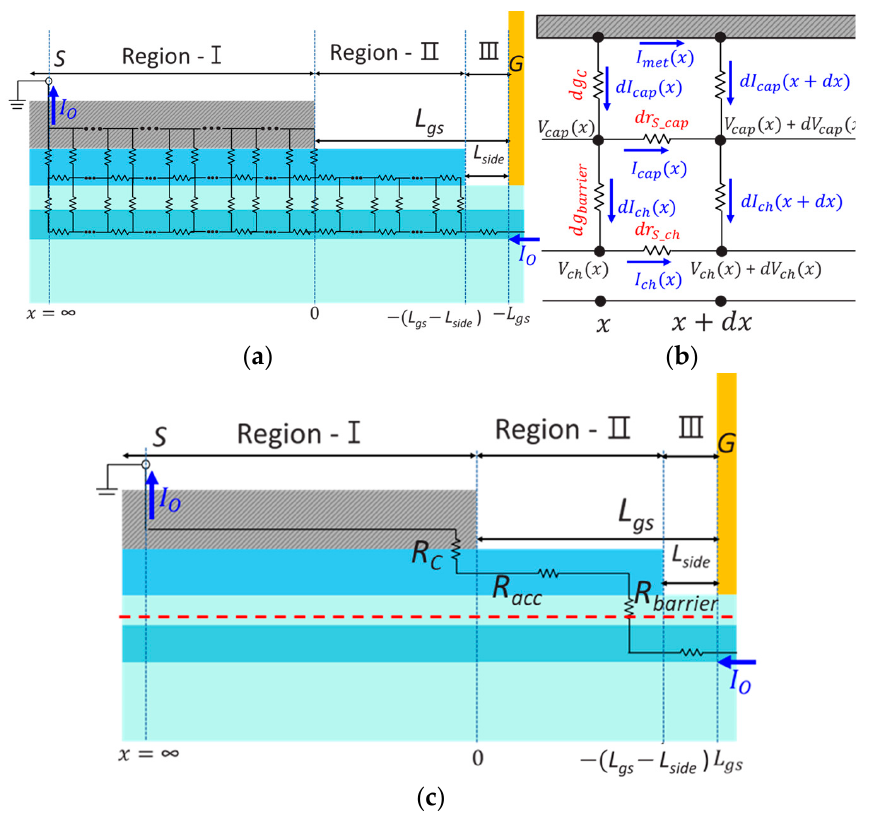
Figure 2. ( a ) Equivalent circuit model of the source structure in the advanced HEMTs, ( b ) differential segment from x to x + dx , and ( c ) lumped-elements based one-layer model.